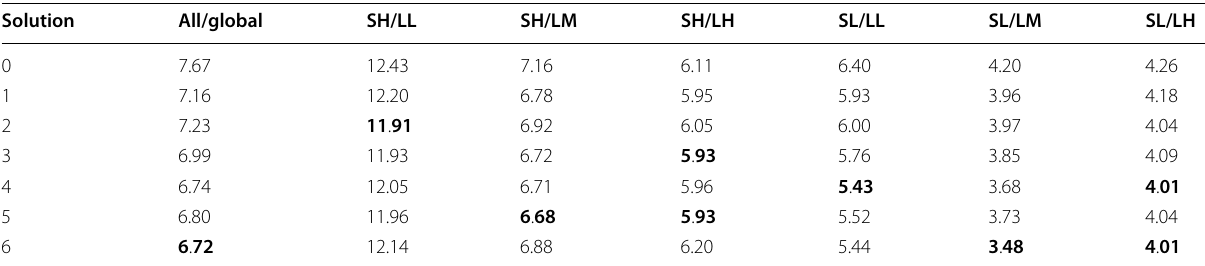
Table 2 Mean standard deviation of differences to dual-frequency correction for different regions (LL: low latitudes; LM: mid-latitudes; LH: high latitudes) and solar activity (SH: high solar activity; SL: low solar activity) and for all Jason-1 data (all/global); all numbers in mm; best solution in bold